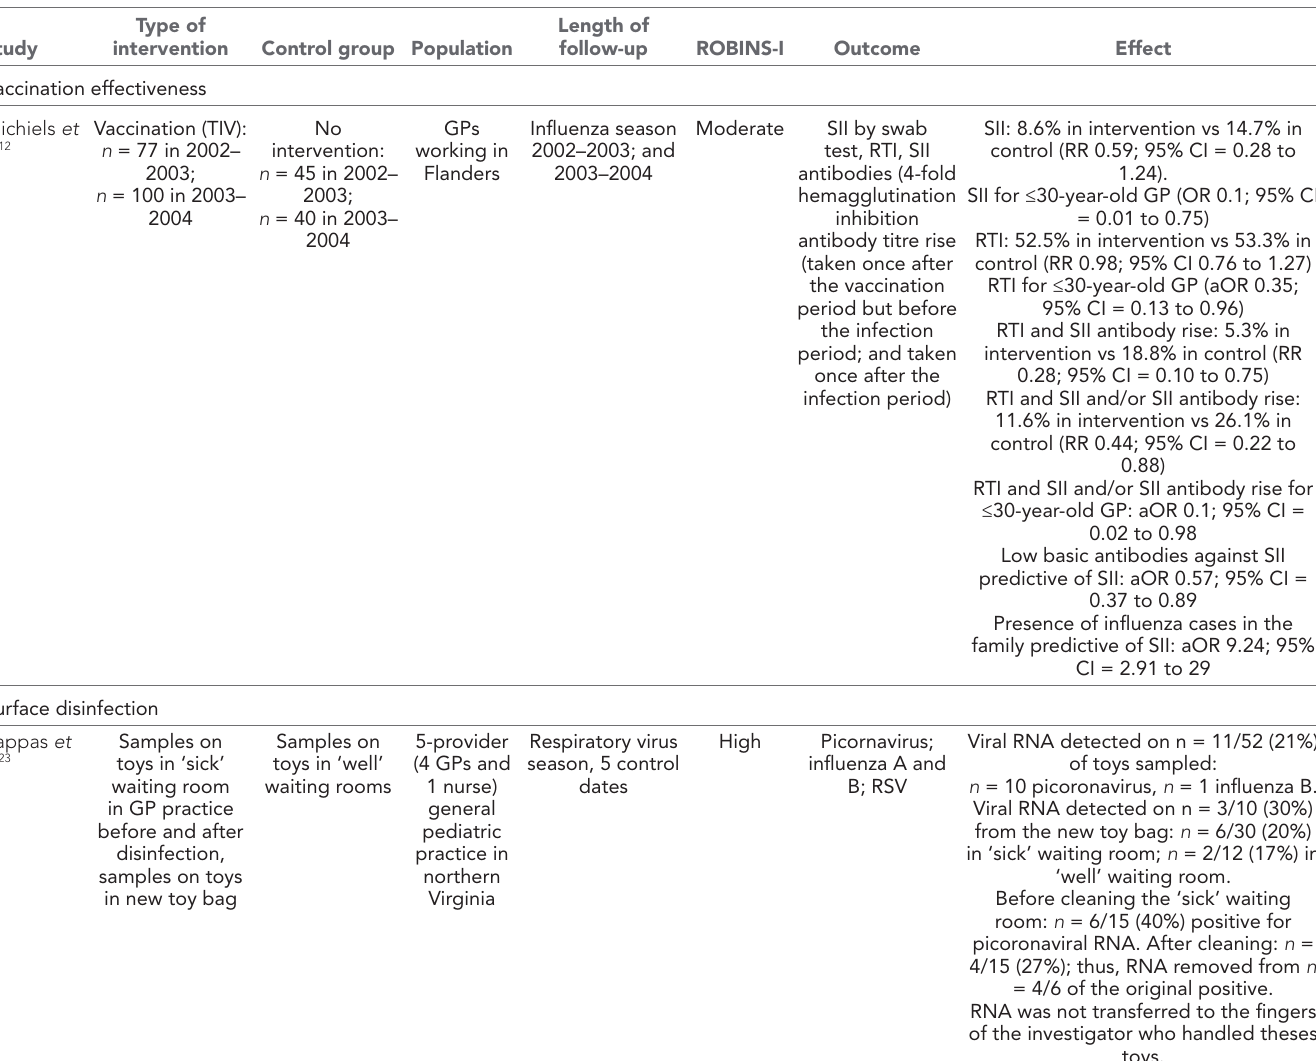
Table 1 Summary of all data extraction